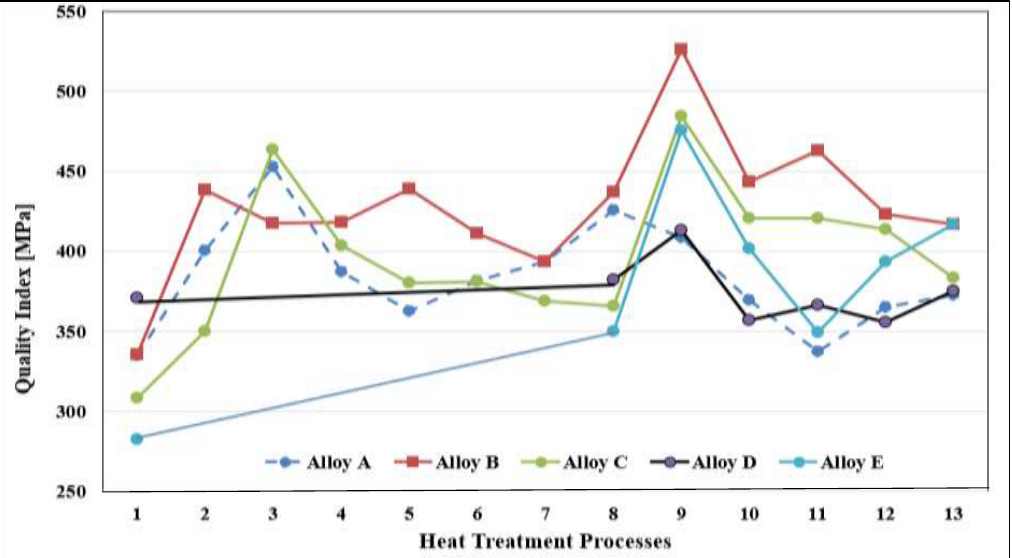
Figure 12. Quality chart showing the relationship between UTS and %El for the D and E alloys investigated in the as-cast and six heat treatment conditions (with SHT for 8 h).